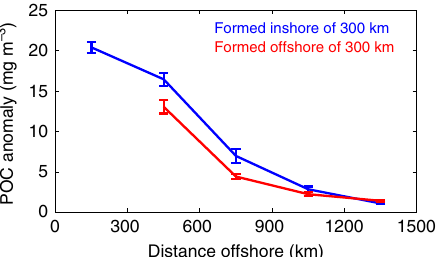
Fig. 4 Particulate organic carbon anomaly as a function of distance from the coast. Mean particulate organic carbon anomaly (mg m − 3 ) and standard error within one eddy radius for cyclonic eddies formed inshore of 300 km from the coast (blue line) and for those formed offshore of 300 km (red line) as the eddies propagate